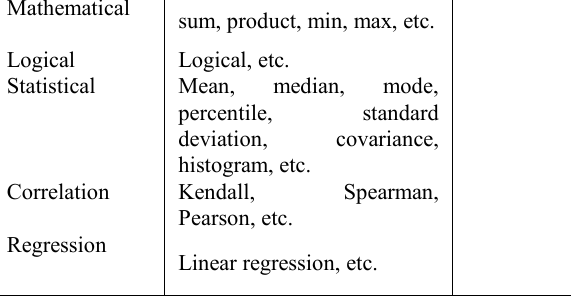
Table 2. Earth Engine Reducers function